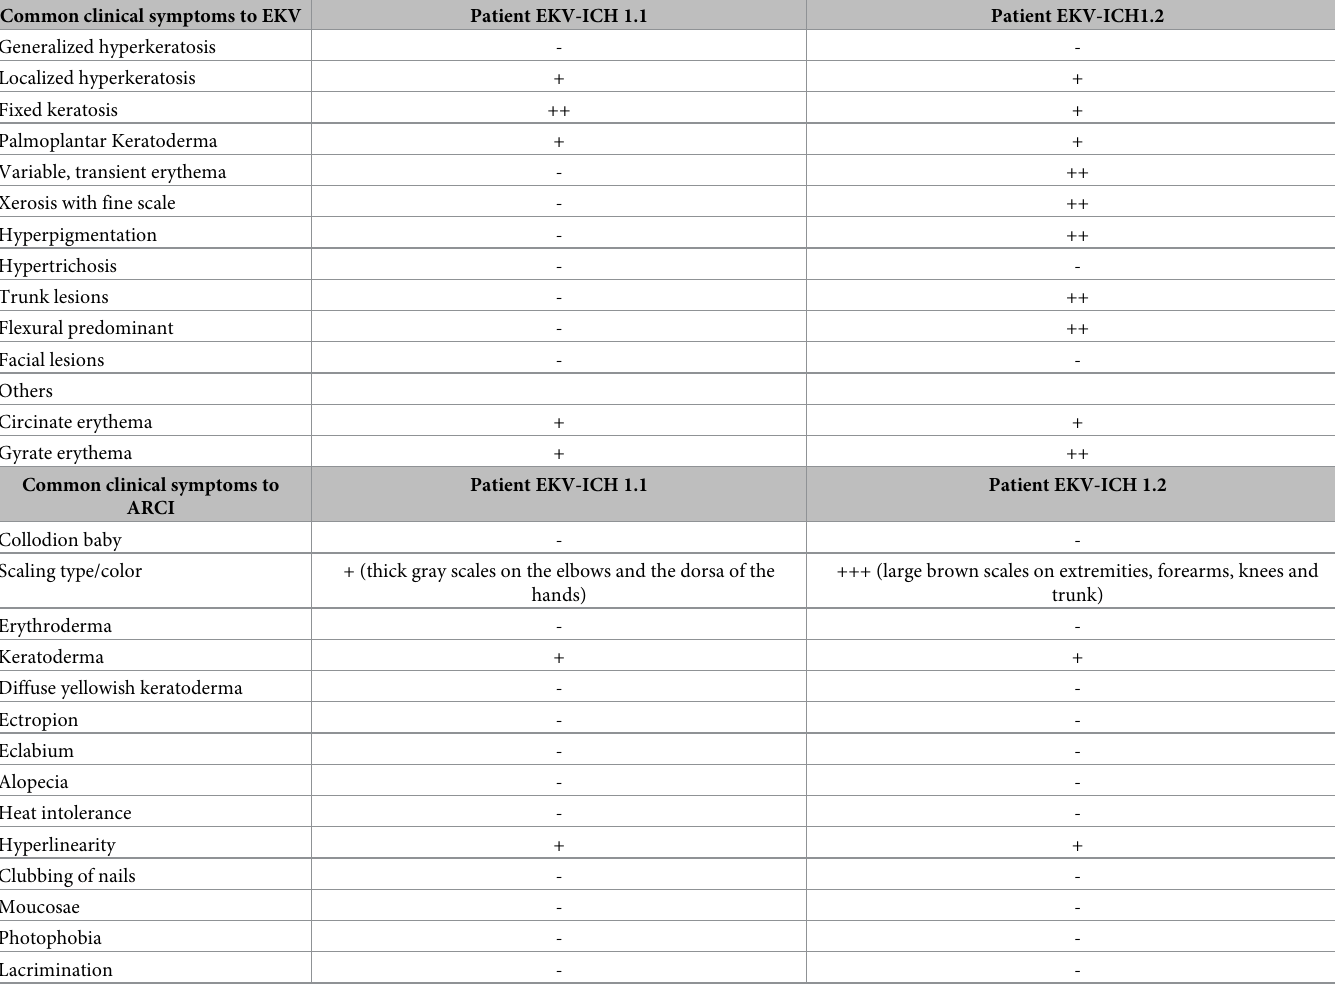
Table 3. Specific clinical symptoms of EKV and ARCI reported in the literature and clinical features of patients EKV-ICH1.1 and